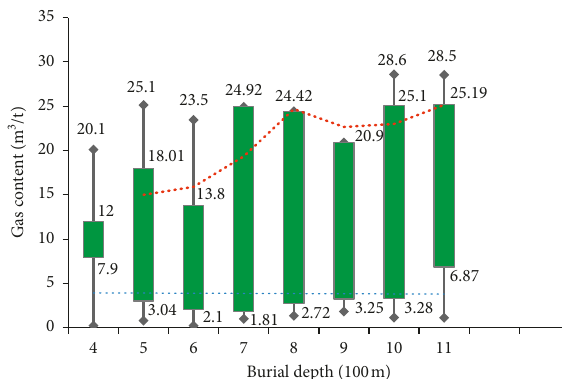
Figure 5: Box plot of gas content and burial depth in Qinshui